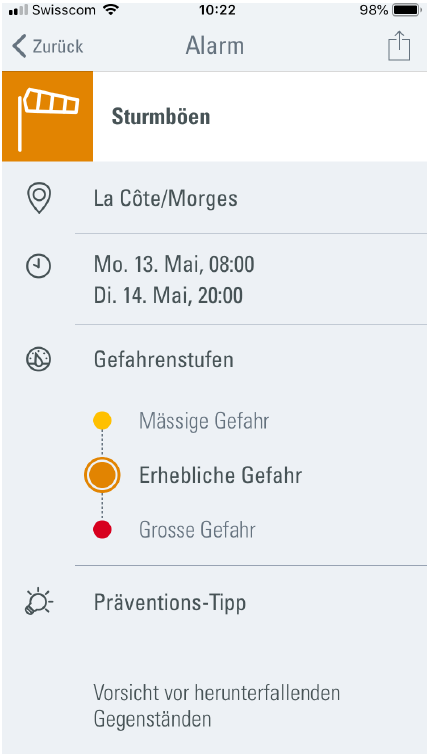
Figure 1. Standard wind warning of medium severity level for the region La